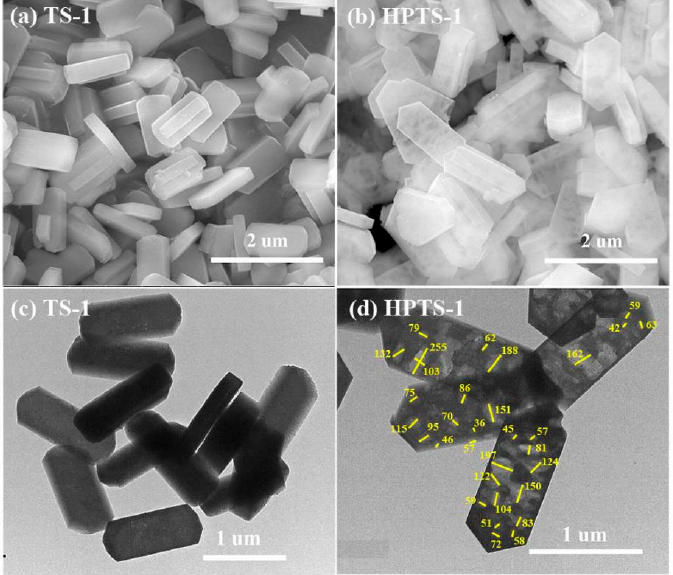
Figure 1. SEM ( a , b ) and TEM ( c , d ) images of TS-1 and hierarchically porous titanium silicalite-1 (HPTS-1) samples.